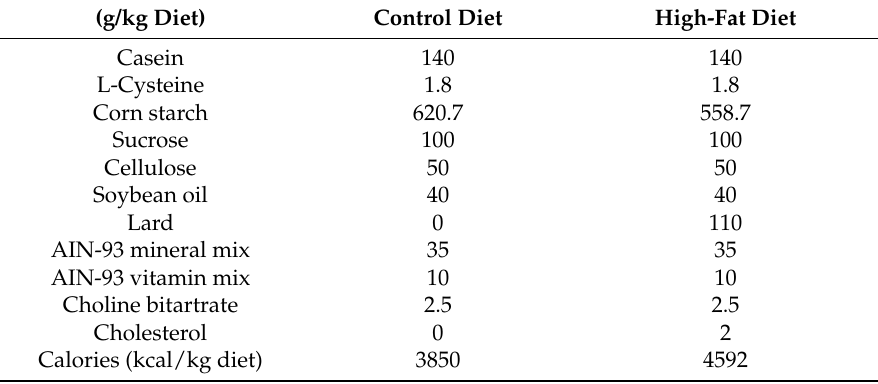
Table 1. Ingredient composition of the experimental diets fed to